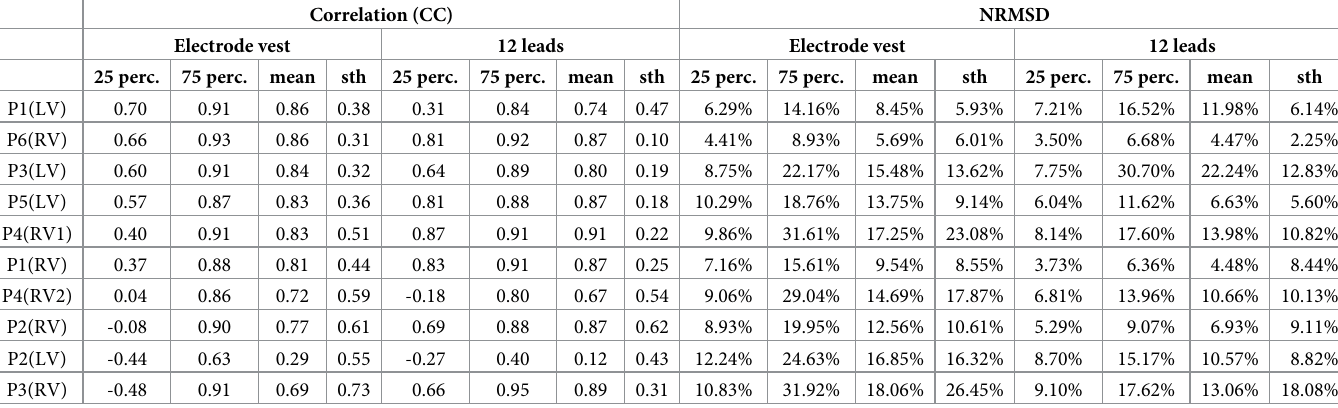
Table 4. Summary of correlation coefficient (CC) and NRMSD values for simulated and measured ECGs.